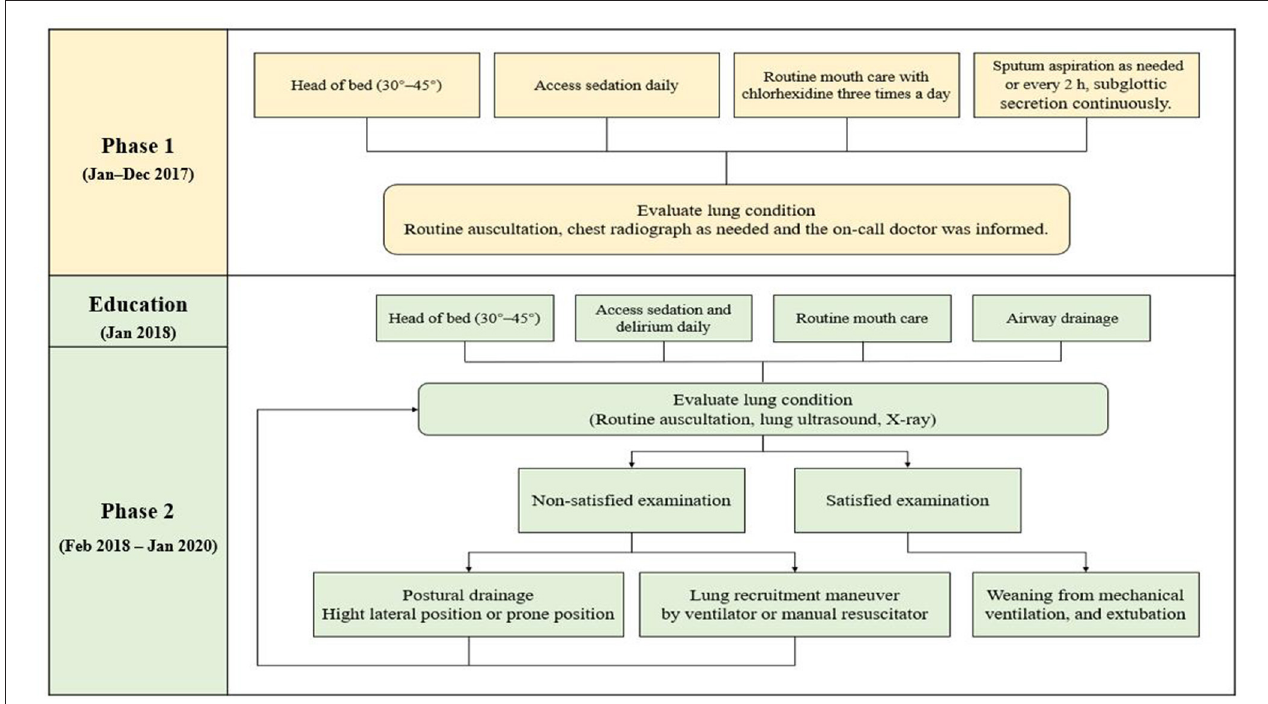
FIGURE 2 | The protocols for pneumonia in the pre- and post-protocol